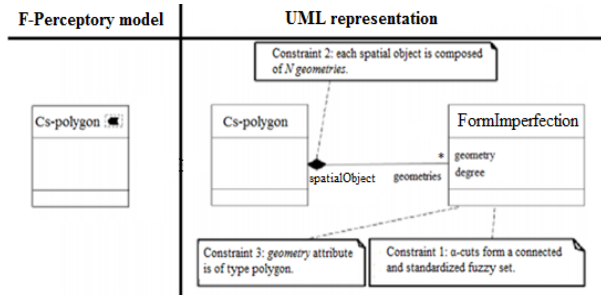
Figure 2. Transformation of a simple fuzzy polygon to UML